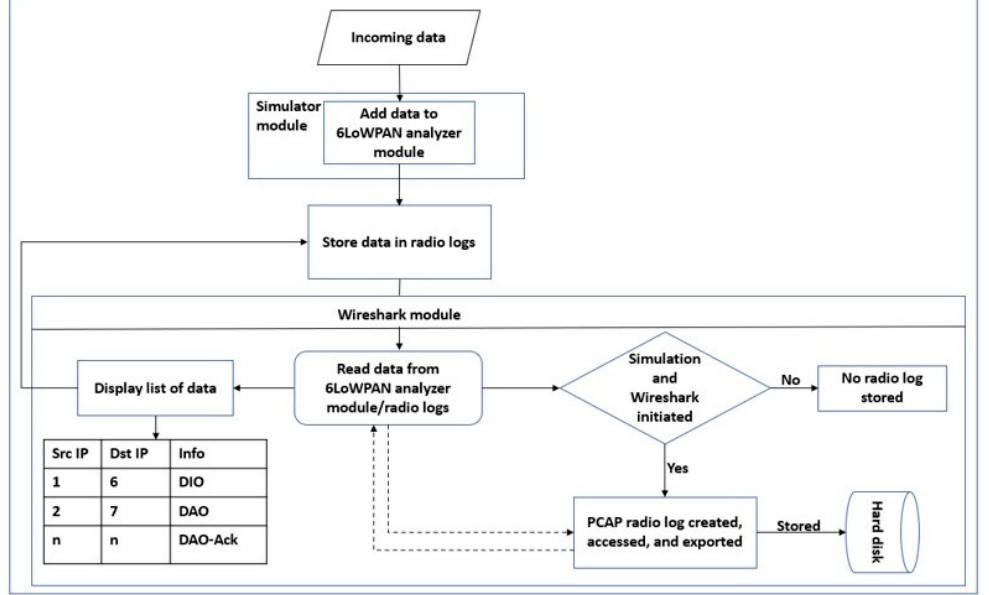
Figure 4. Workflow of data collection module.